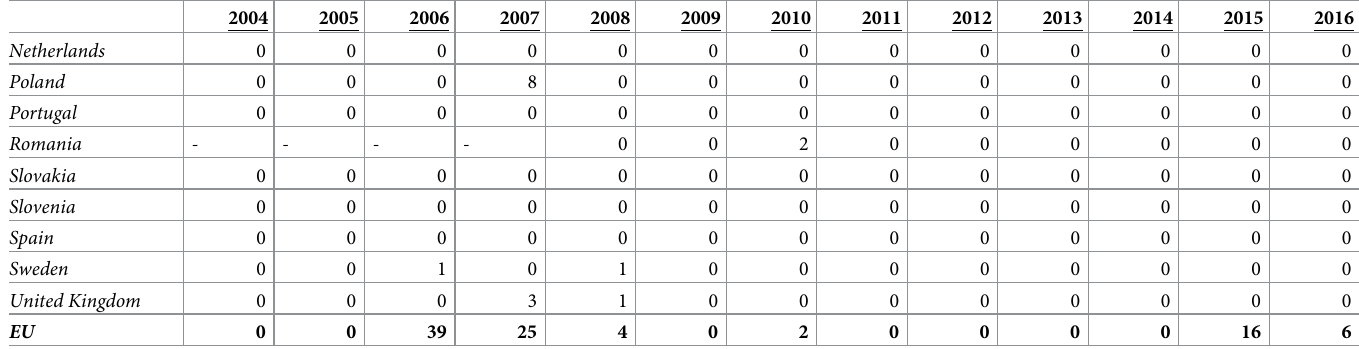
Chmura (4) also identified IBAs as a proxy for migratory birds and the infection risks they